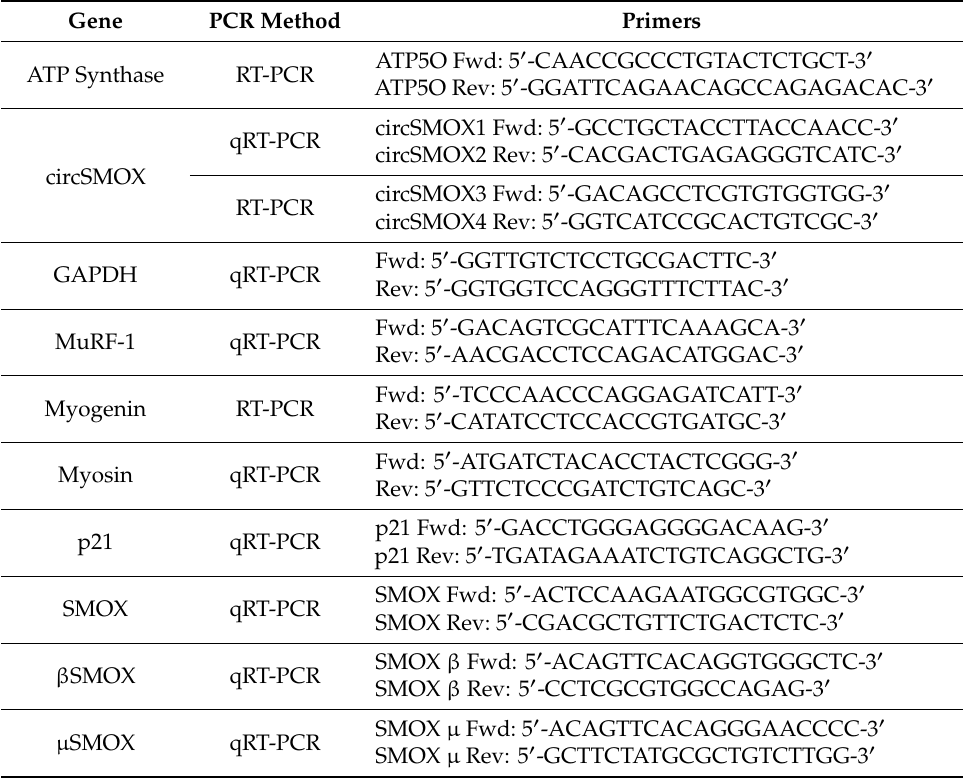
Table 1. Primers used in this